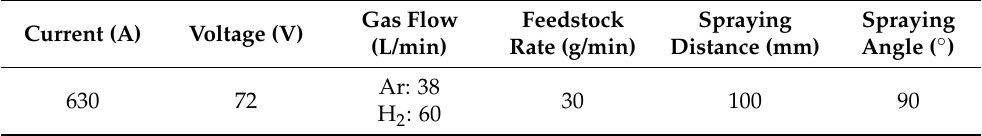
Figure 1. ( a ) The SEM micrograph of as-synthesized 8YSZ:Eu 3+ powder particles; ( b ) histogram with the size distribution of the particles; ( c ) SEM images of cross-sectional microstructures of the as-prepared 8YSZ:Eu 3+ coating samples; inset image shows the high-magnification SEM image of local region in ( c ). Table 1. Spaying parameters of the 8YSZ:Eu 3+